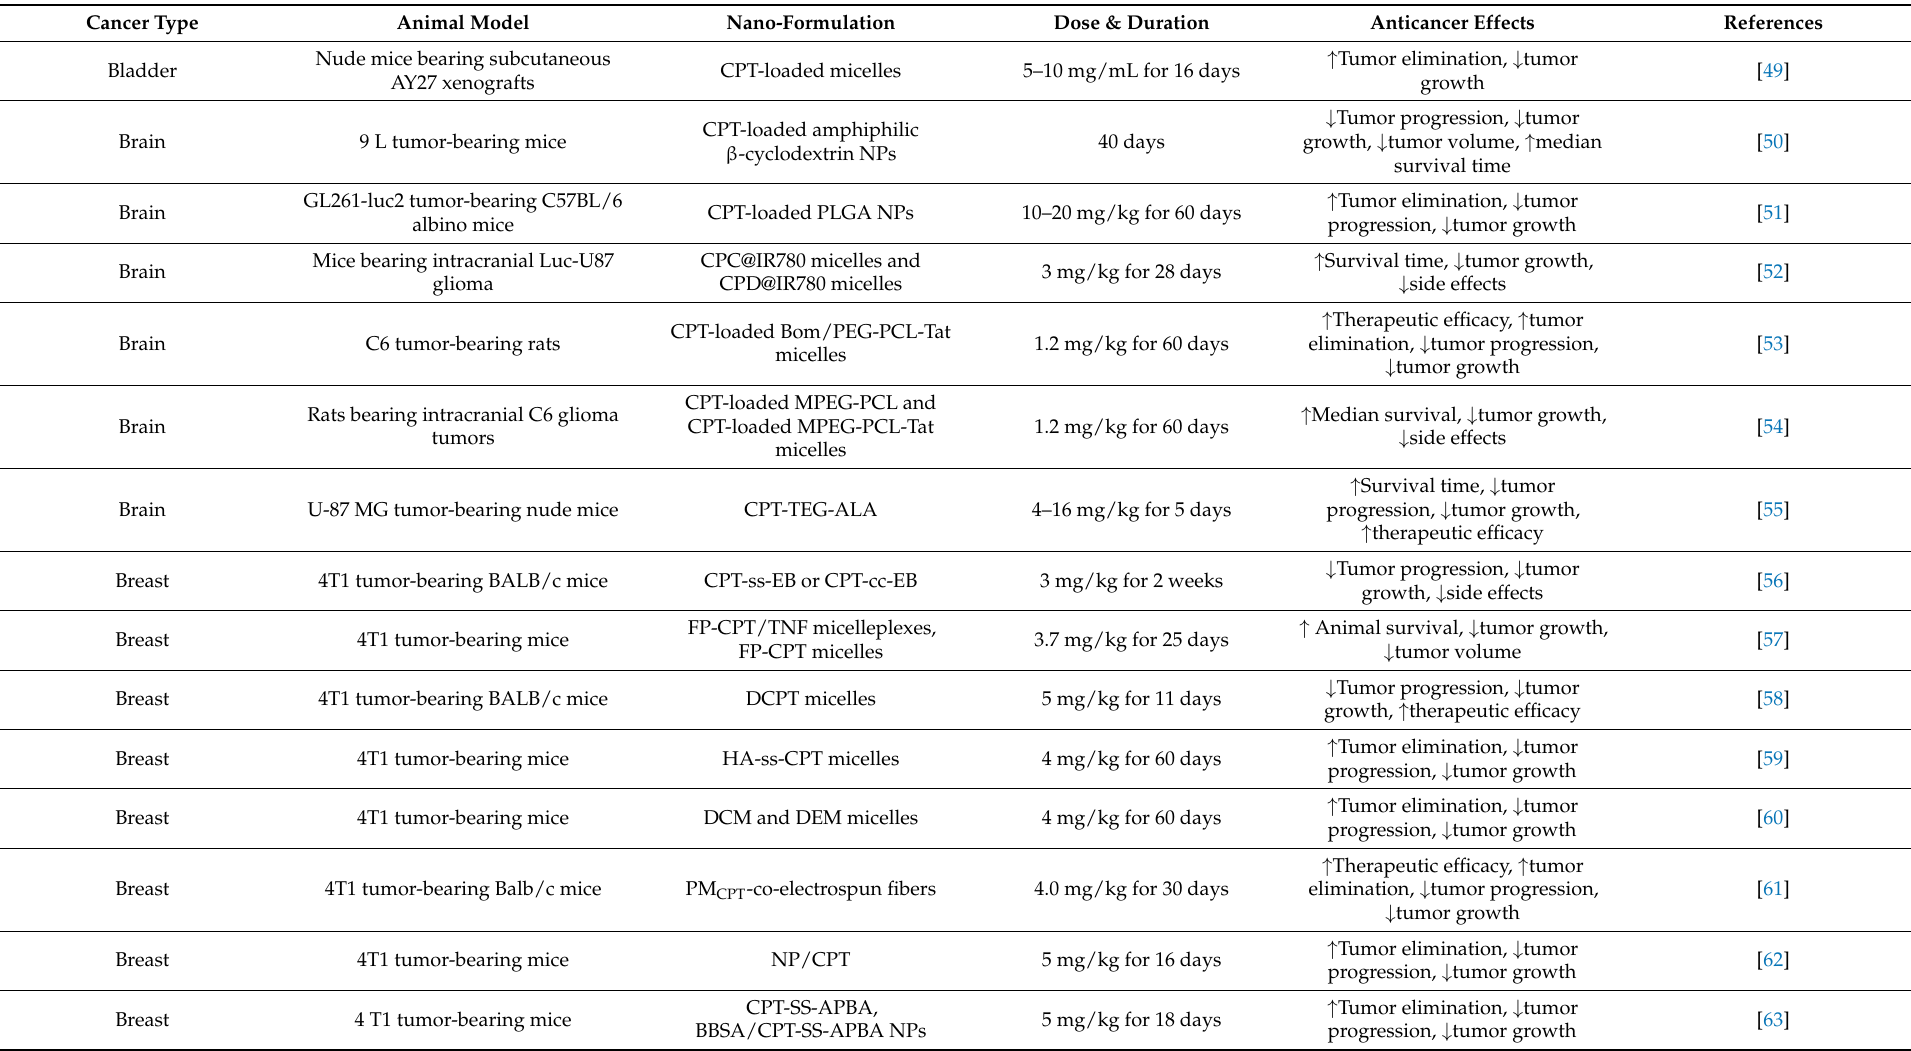
Table 1. Potential antitumor impacts of CPT nano-formulations based on in vivo